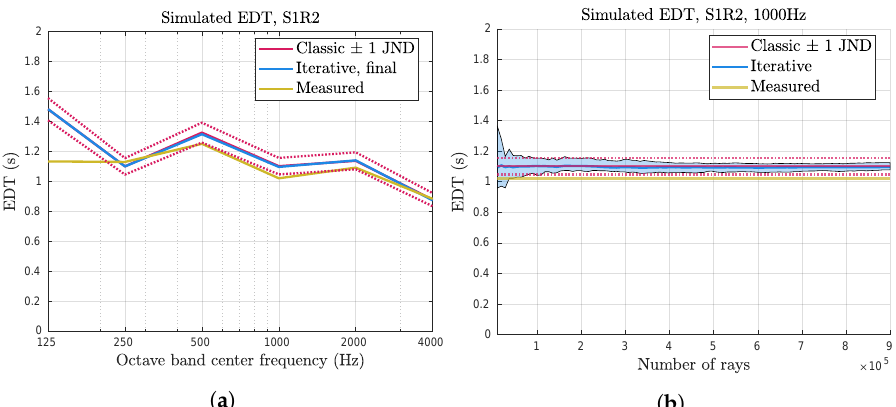
Figure 10. Early decay time EDT for one position, measured and estimated from classic and iterative simulation data sets. In ( a ), the results for the maximum number of rays are shown. ( b ) shows the estimate for 1000 Hz increasing the number of rays in the iterative algorithm and showing the results for the full classic simulation. The shaded area illustrates the spread of estimates in the iterative algorithm.